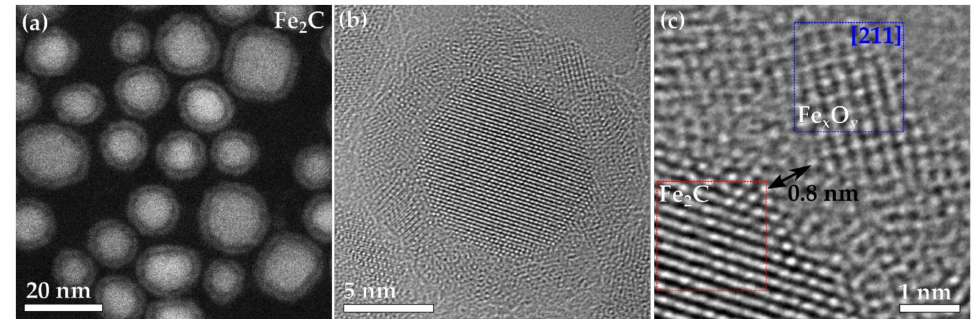
Figure 2. ( a ) HAADF-STEM image of the Fe 2 C nanoparticles. ( b ) Aberration-corrected HRTEM of a whole particle of Fe 2 C. ( c ) A zoomed in area focusing on the Fe x O y shell and the void between it and the Fe 2 C